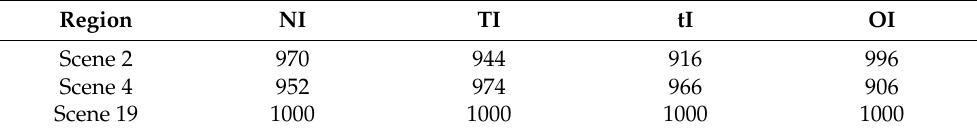
Table 2. Number of samples selected for each type of sea ice test set in the three images.